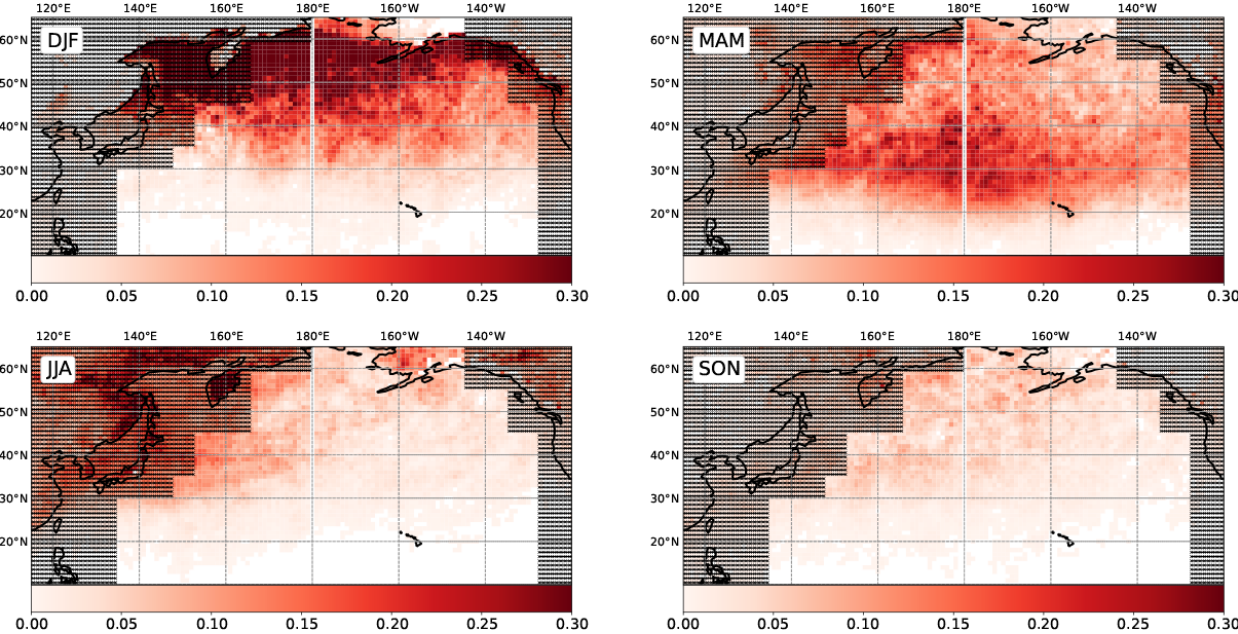
Figure 3. All panels in this plot show the same quantity as in Fig. 1b, though separately for each season and solely for the Pacific region (i.e. the global frequency distribution (2000–2019) of the 2% of data points weighted by the total number of valid retrievals at each grid point). Only CO maxima in the area which is not grey shaded are included in the trend and trajectory